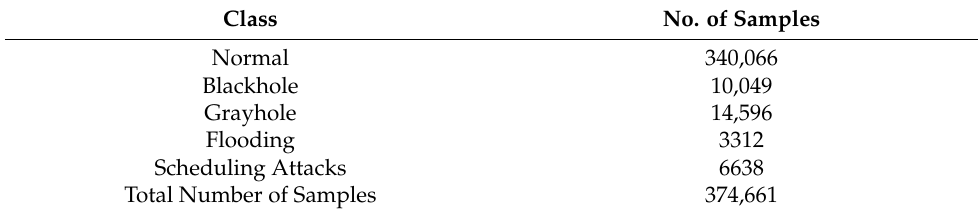
Table 1. Details of the dataset.